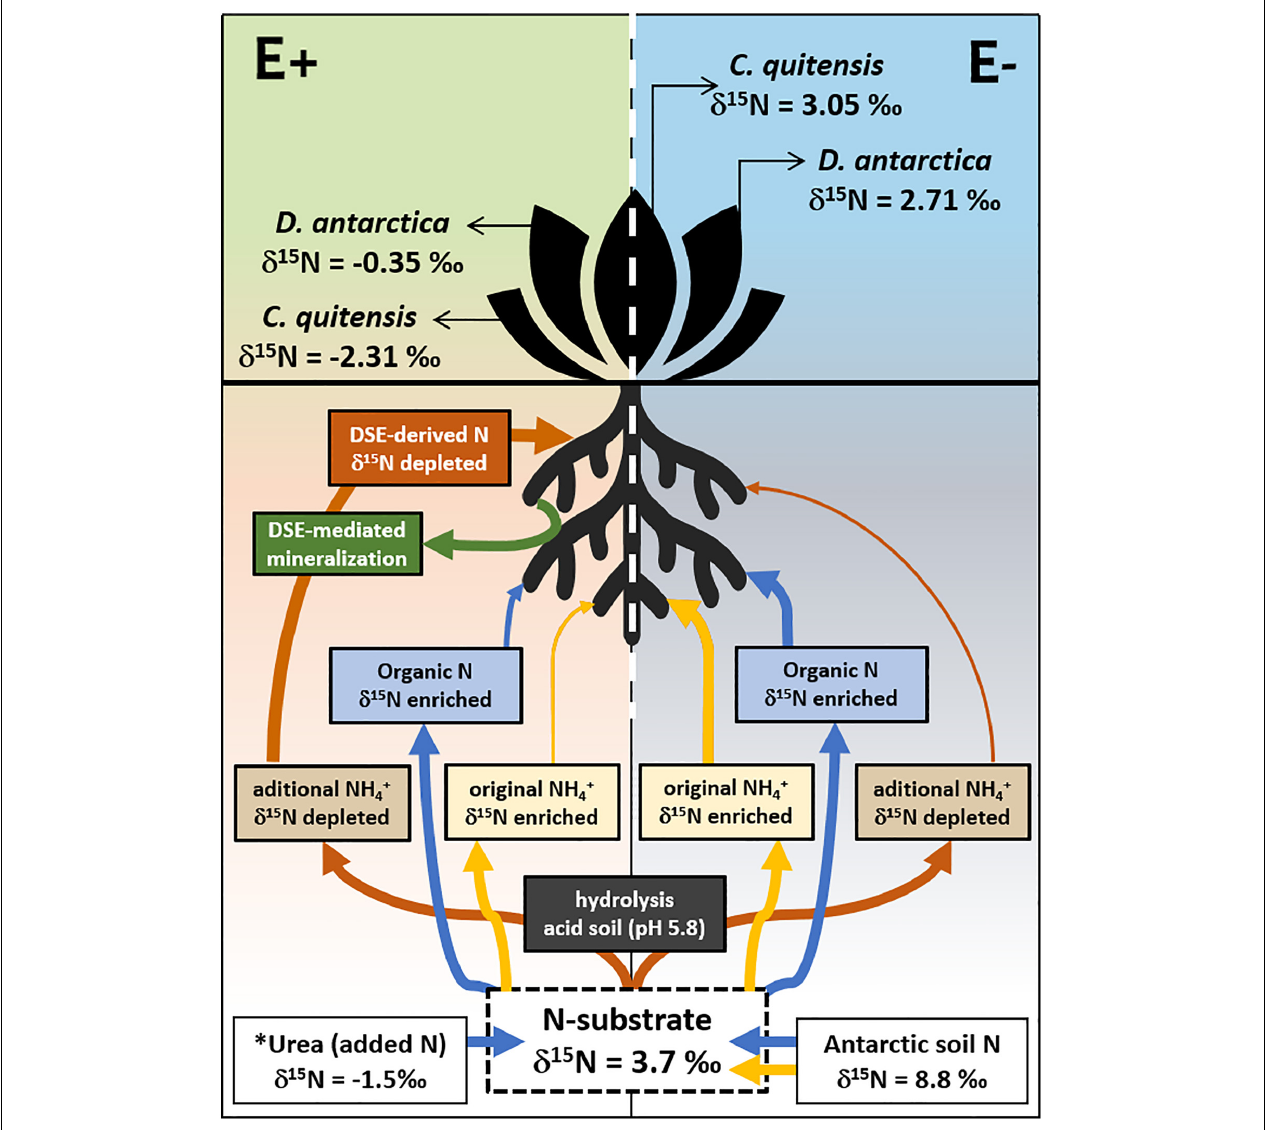
FIGURE 5 | Proposed model of the DSE-Plant interaction for N uptake in the vascular Antarctic plants Deschampsia antarctica and Colobanthus quitensis , determined by the d15N signature in soil and leaves. E denote non-infected plants while E+ their DSE-infected counterpart. Arrow’s width imply preferred N-substrates uptaked/assimilated while their color represents its form in the soil (blue: organic; red/yellow: inorganic). The proportion of the urea added (8 g/kg) was equivalent to the previously estimated total N content of the experimental substrate (see methods for details). ∗ Note that the urea added to the incubations are much more 15N depleted than the Antarctic soil used. Eliminado: Mineralization of organic N as described by the accumulation of NH4+ in the substrate of endophyte free (E − , in gray) and endophyte-infected (E+, in green) individuals of the two Antarctic vascular plant species. Boxplots represent the inter-quartilic distribution of the data ( n = 7), different letters denote significant differences after a factorial pairwise comparison using Estimated-Marginal Means (EMMs) analysis with a 0.95 confidence